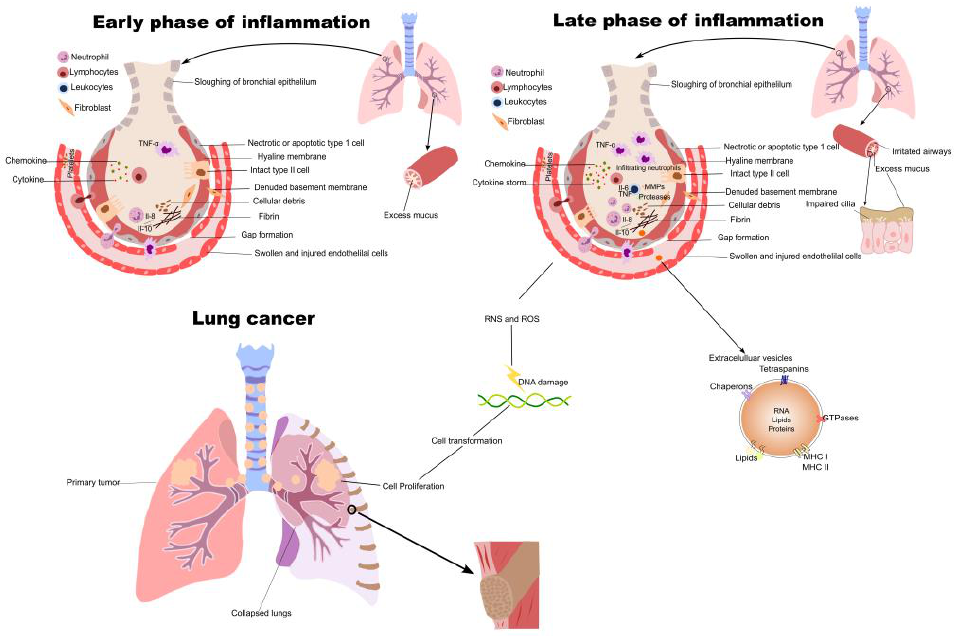
Figure 1. Neutrophils have a significant impact on early event of acute lung inflammation. The formation of granulation tissue, which is made up of cellular matrix, fibroblasts, endothelial cells, and leukocytes, is orchestrated by neutrophil migration and chemokine production during acute inflammation. Inflammation becomes chronic when acute inflammation is not treated. Other inflammatory immune cells, such as macrophages and lymphocytes, intensify lung inflammation during chronic inflammation, increasing the risk of cancer by fostering tumorigenesis at all stages, including initiation, invasion, and metastasis. Lung cancer progression is also aided by inflammation because it supplies the tumor microenvironment with vital molecules by the help of extracellular vesicles. A hallmark of lung inflammation is immune cell infiltration. Immune cells infiltrate can be divided into innate and adaptive immune cells [26]. Innate immune cells, such as dendritic cells, myeloid-derived suppressor cells (MDSCs), TAMs, and neutrophils, can either promote or suppress tumor initiation and progression during tissue injury [27]. Den- dritic cells mediate antitumoral immunity by cross-presenting tumor antigens to activate T-lymphocytes in lymph nodes [28]. MDSCs degrade L-arganine, and inhibit NK cell- derived IFN- γ production as well as CD4 and CD8 T cell IFN- γ production [29]. MDSCs curb T cell activity by downregulating pro-inflammatory cytokines, such as prostaglandin E2 (PGE2) and IL-12, reducing host immunity to target cancerous cells (Huang et al.,